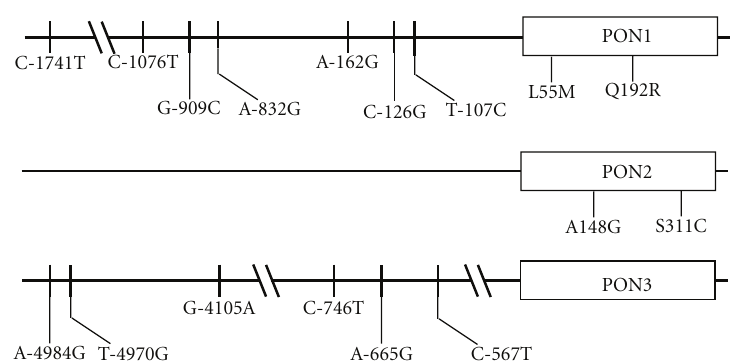
Figure 1: Schematic representation of the most prevalent polymorphisms of the PON1, PON2, and PON3 genes.